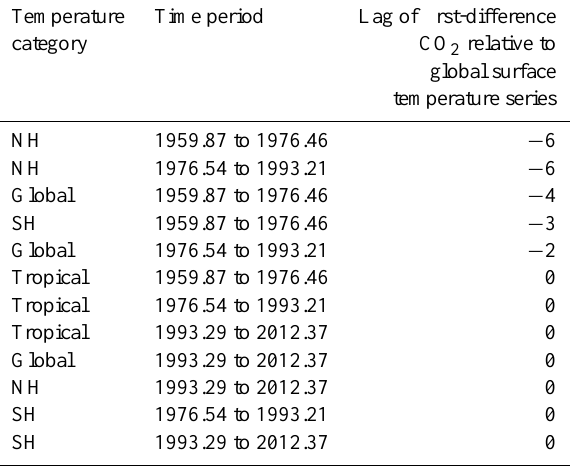
Table 2. Lag of first-difference CO 2 relative to surface tempera- ture series for global, tropical, Northern Hemisphere and Southern Hemisphere categories, each for three time-series